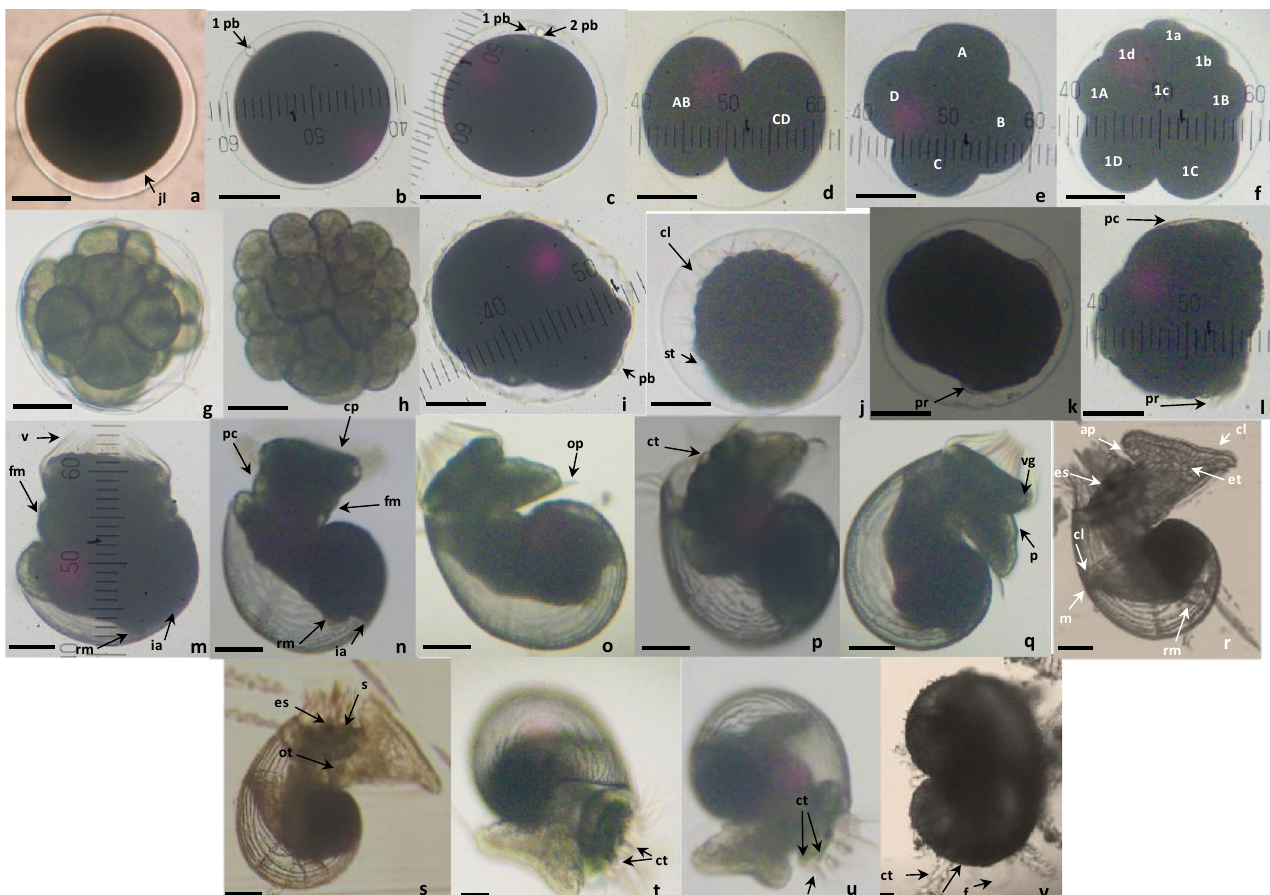
Fig. 5. Cittarium pica . Embryonic development in the fi rst 97 days post-fertilization: (A) recently spawned oocyte with dissolved germinal vesicle and a jelly layer (jl). (B, C) Expulsion of polar bodies (pb). (D, E) First and second cleavages result in macromers (A, B, C and D) and micromers (a, b, c and d). (F, G) Third and fourth cleavages. (H) Morula. (I) Blastula. (J) Gastrula with cilia (cl) and stomodeum (st). (K) Intra- capsular trochophore larvae with prototroch (pr). (L) Hatched trocophore with protoconch (pc). (M) Pre-torsional veliger with ciliated velum (v) and retractor muscle (rm). (N – S) Post-torsional veliger with foot mass (fm), integumental attachment (ia), operculum (op), cephalic tentacle (ct) and propodium (p), eye spot (es), cl in p and in mantle cavity (m), epipodial tentacles (et), apophysis (ap) on the p, otolith (ot) and snout protrusion (s). (T, U) Formation of two, three and four tubules (tb) in the ct. (V) Crawling veliger with foot (f). Bar size = 80 m